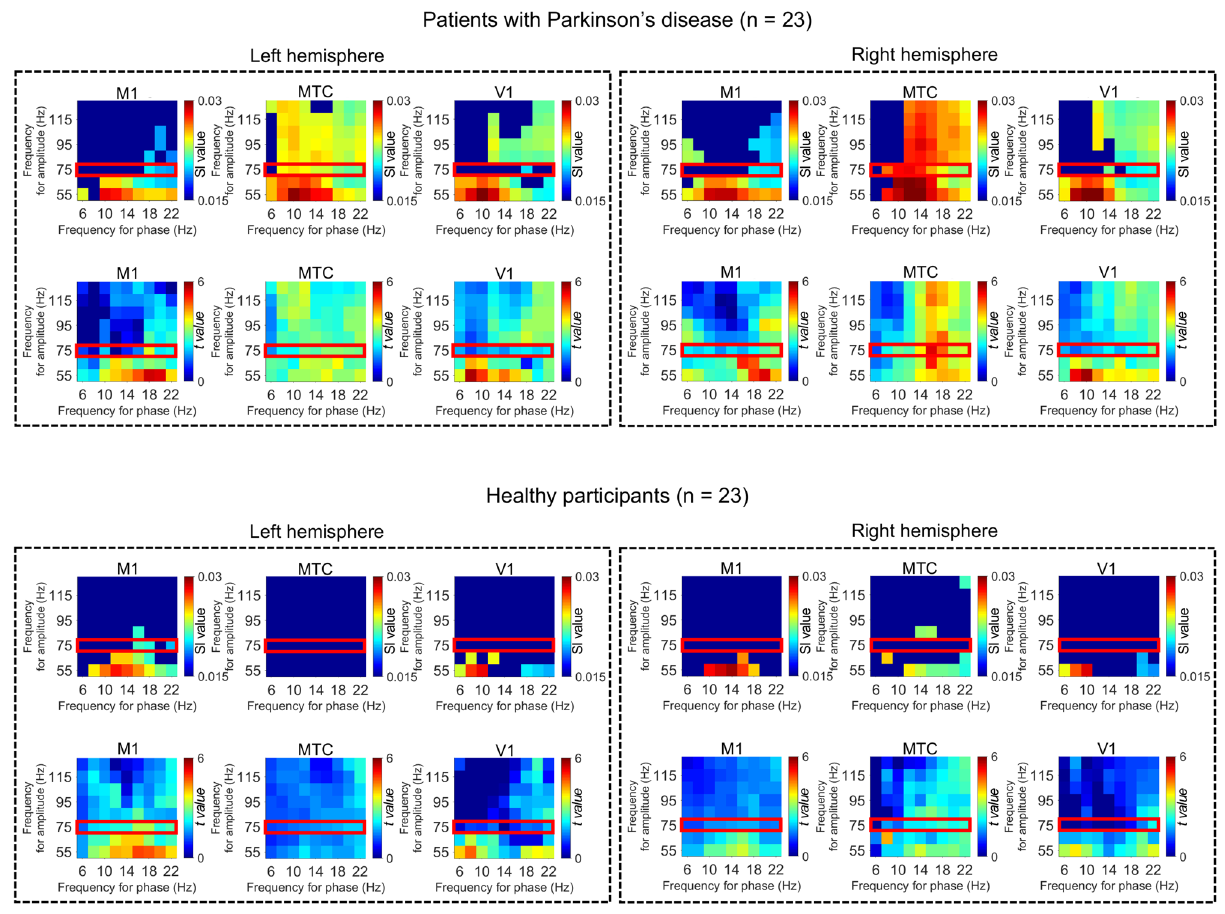
areas and averaged for each cortical area. The primary motor cortex (M1, Human Connectome Project [HCP] parcel #8), the anterior middle temporal cortex (MTC, HCP parcel #134), and the primary visual cortex (V1, HCP parcel #1) of both hemispheres were selected as representative cortical areas. The SI values were averaged for each participant group, and only SI values that significantly exceeded the phase-shuffled SI values were plotted ( P < 0.05, 2-tailed paired Welch t test , false discovery rate corrected). Each phase has a 4 Hz frequency range (that is, “6 Hz” in frequency for phase corresponds to “4–8 Hz”), and each amplitude has a 50 Hz frequency range (that is, “55 Hz” in frequency for amplitude corresponds to “30–80 Hz”). The corresponding t value s are shown below each of the SI values. The red squares indicate the SI values for gamma amplitude (50–100